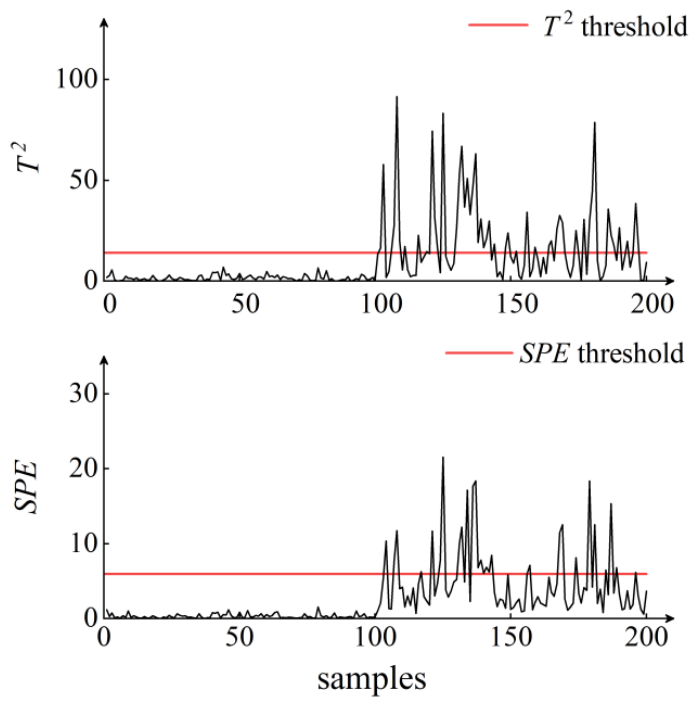
Figure 12. PLS monitoring of sample 2.